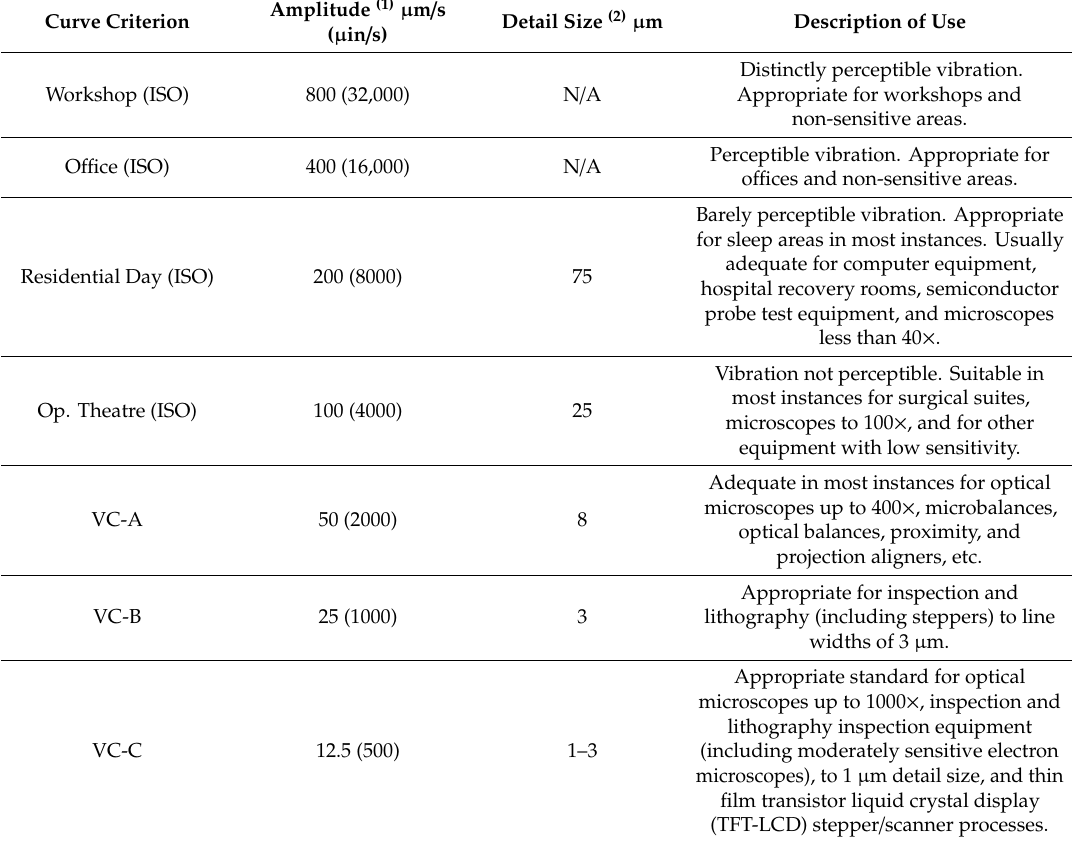
TableA1. Vibrationcriteria(VC)fornano-ormicro-electro-mechanicalsystems(MEMS)equipment[5–8] Table A1. Vibration criteria (VC) for nano-or micro-electro-mechanical systems (MEMS) equipment [5–8] are summarized are summarized below.